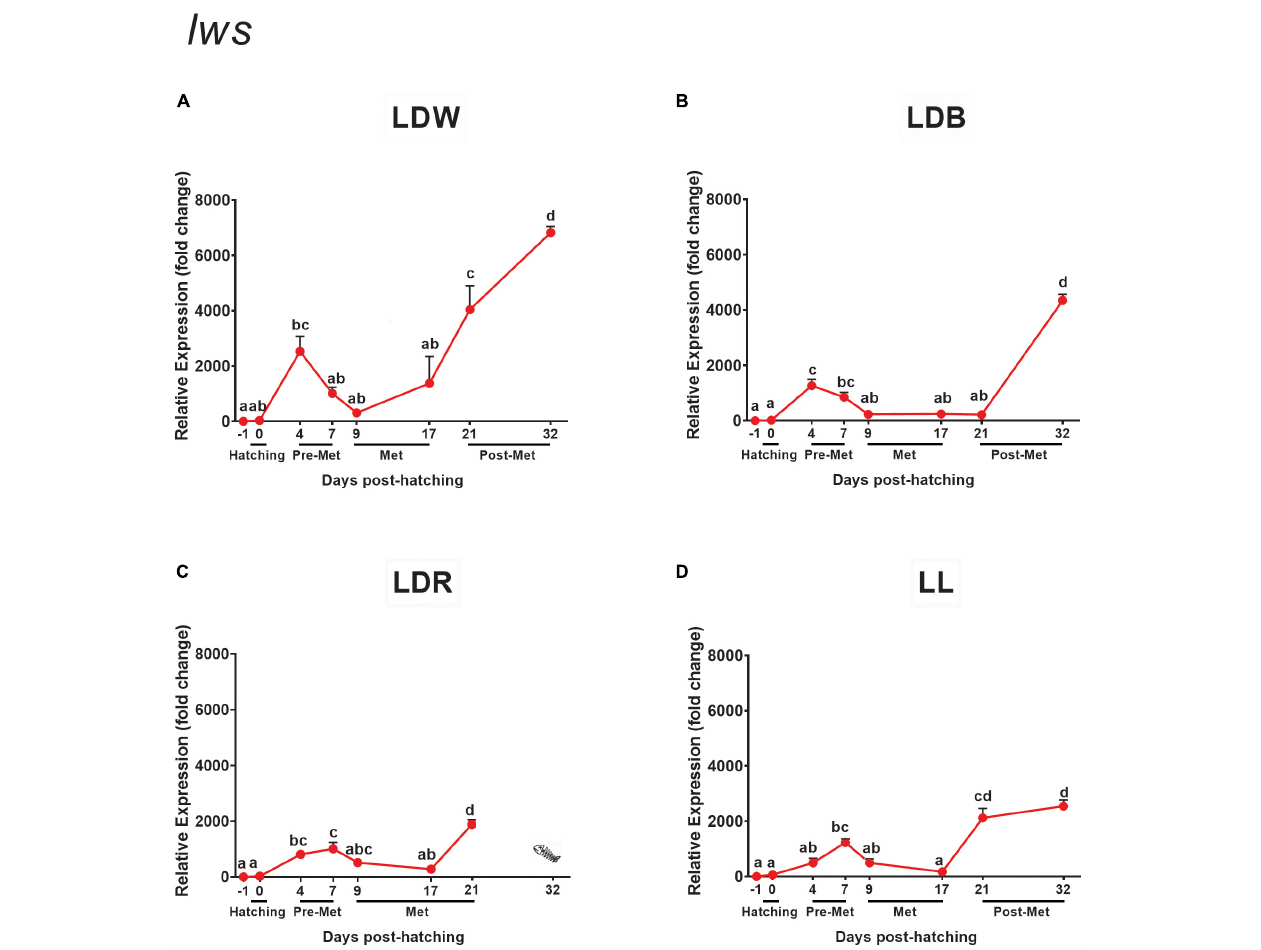
FIGURE 10 | Expression of red cone opsin ( lws ) in embryos, larvae, and juveniles of the Senegalese sole on dph –1 (embryos), dph 0 (hatching), dph 4–7 (pre-metamorphosis, Pre-Met), dph 9–17 (metamorphosis, Met), and dph 21–32 (post-metamorphosis, Post-Met) analysed by RT-qPCR. For further information, see the legend in Figure 1